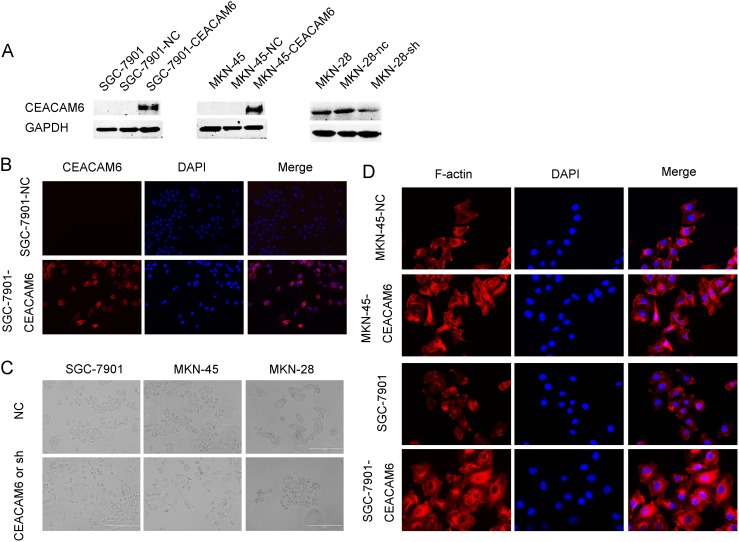
Effects of CEACAM6 on cell morphology and cytoskeleton in GC cells.(A) Stable overexpression and suppression of CEACAM6 in GC cells. (B) CEACAM6 expression was analyzed by immunofluorescence, and more CEACAM6 expression was detected in CEACAM6-overexpressing cells than that in control cells (200×). Blue: DAPI; red: CEACAM6. (C) Overexpression of CEACAM6 in SGC-7901 and MKN-45 cells induced a mesenchymal morphology, whereas knockdown of CEACAM6 in MKN-28 cells induced an epithelial morphology (200×). (D) Immunostaining of F-actin in CEACAM6-overexpressing cells and control cells (400×). Red: F-actin; blue: DAPI.